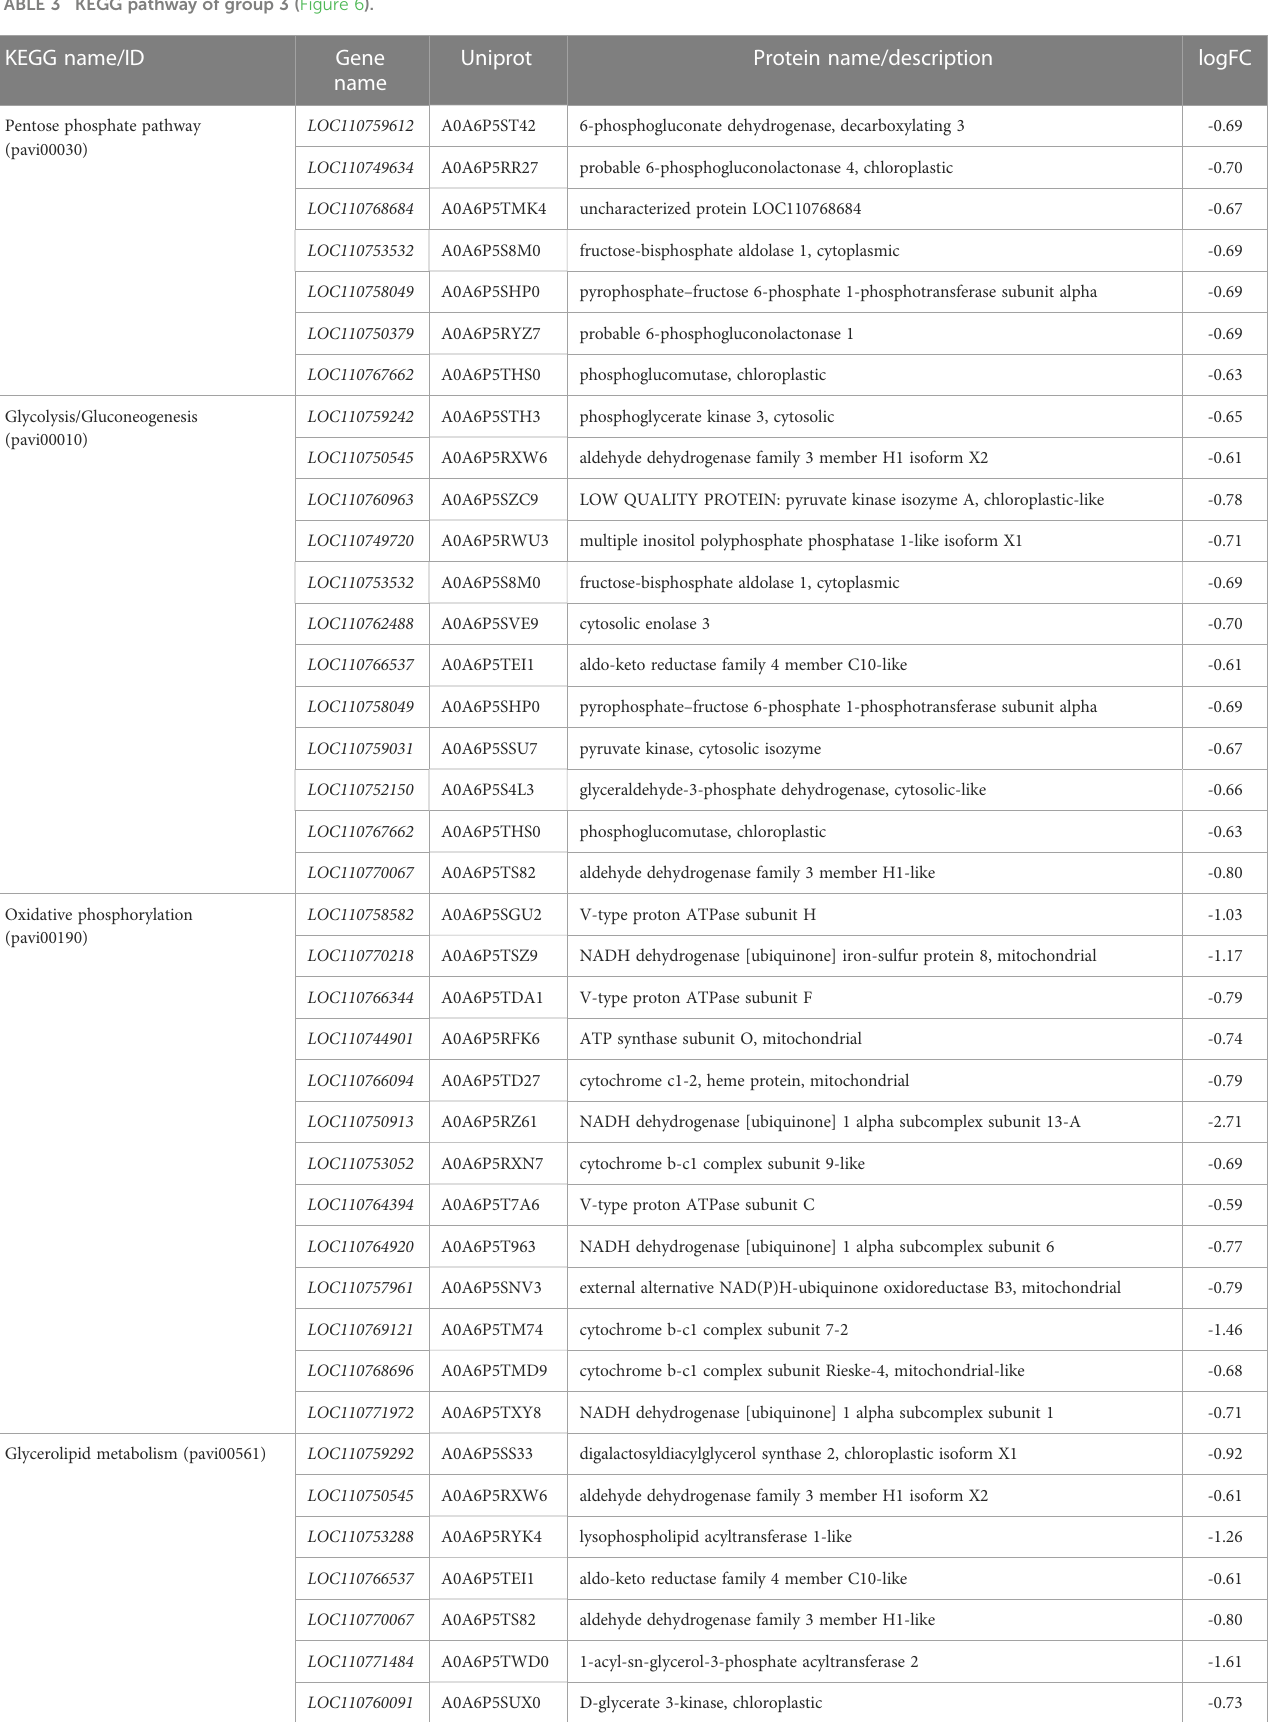
TABLE 3 KEGG pathway of group 3 ( Figure 6